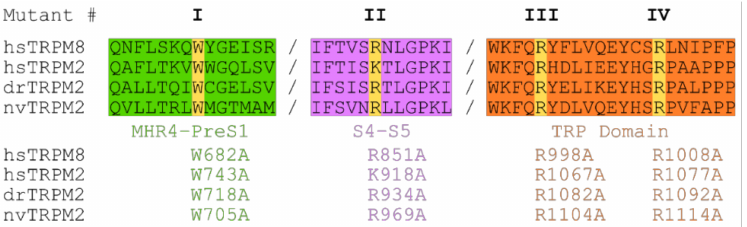
Figure 4. Sequence alignment of TRPM2 and TRPM8. Sequence alignment of the membrane in- terfacial cavity (formed by: Pre-S1 domain and MHR4 from the adjacent subunit (green), junction between S4 and S5 (purple) and TRP domain (orange)) of hs-, dr- and nvTRPM2 and hsTRPM8. Target positions (yellow) within MHR4-PreS1 labelled mutant I (hsW743, drW718, and nvW705), S4–S5 linker labelled mutant II (hsK918, drR934, and nvR969) and TRP domain separated in mutant III (hsR1067, drR1082, nvR1104) and mutant IV (hsR1077, drR1092, nvR1114).